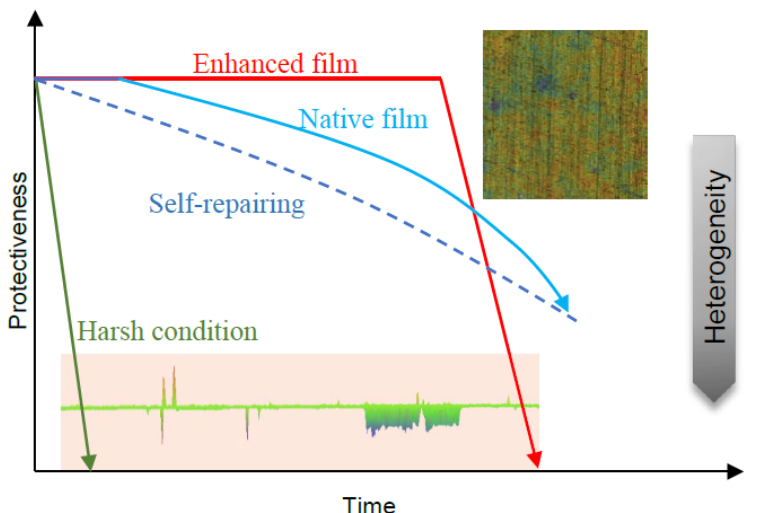
Figure 4. Schematic of critical step for three conditions of pitting: native film without protection under harsh condition (green), native film with excellent self-repairing properties (blue), and the corrosion-resistance enhanced ultrathin oxide film with weak self-repairing properties (red).